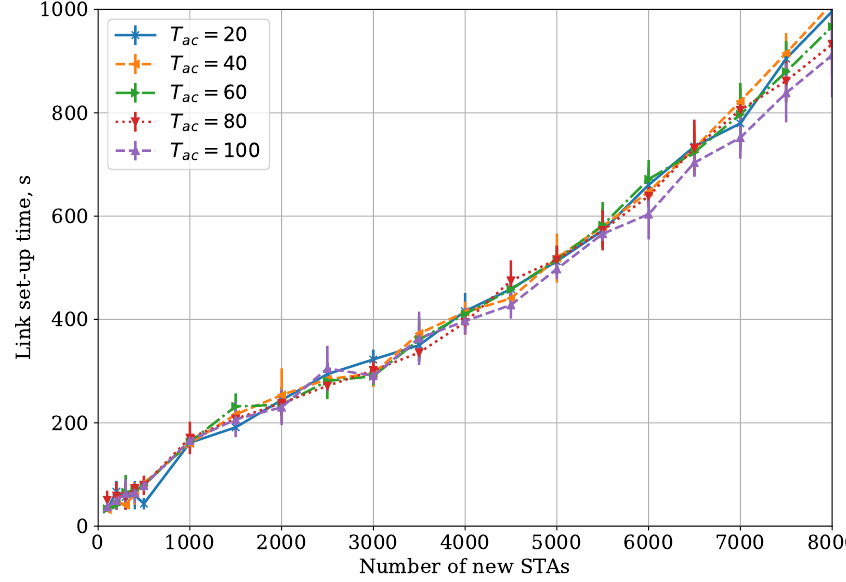
Figure 6. DAC protocol: dependency of link set-up time on the number of new STAs, TI min = 64 for the Small Area case.